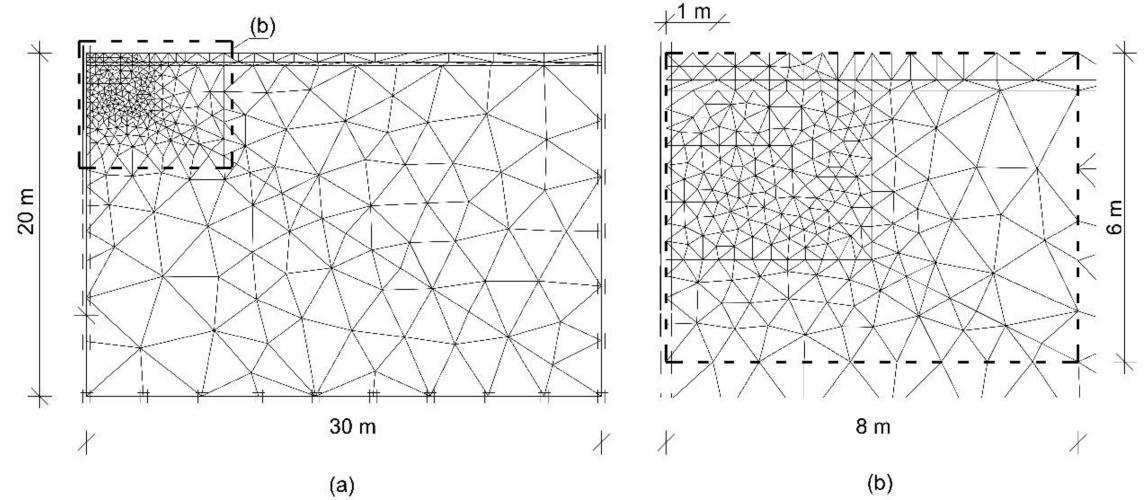
Figure 3. Finite element discretization adopted for the case with B = 1 m and z i /B = 0.5. The mesh is very fine in the proximity of the footing FEM and is larger in the other areas of the domain; ( a ) global mesh, ( b ) enlargement of the part enclosed in the rectangle reported in ( a